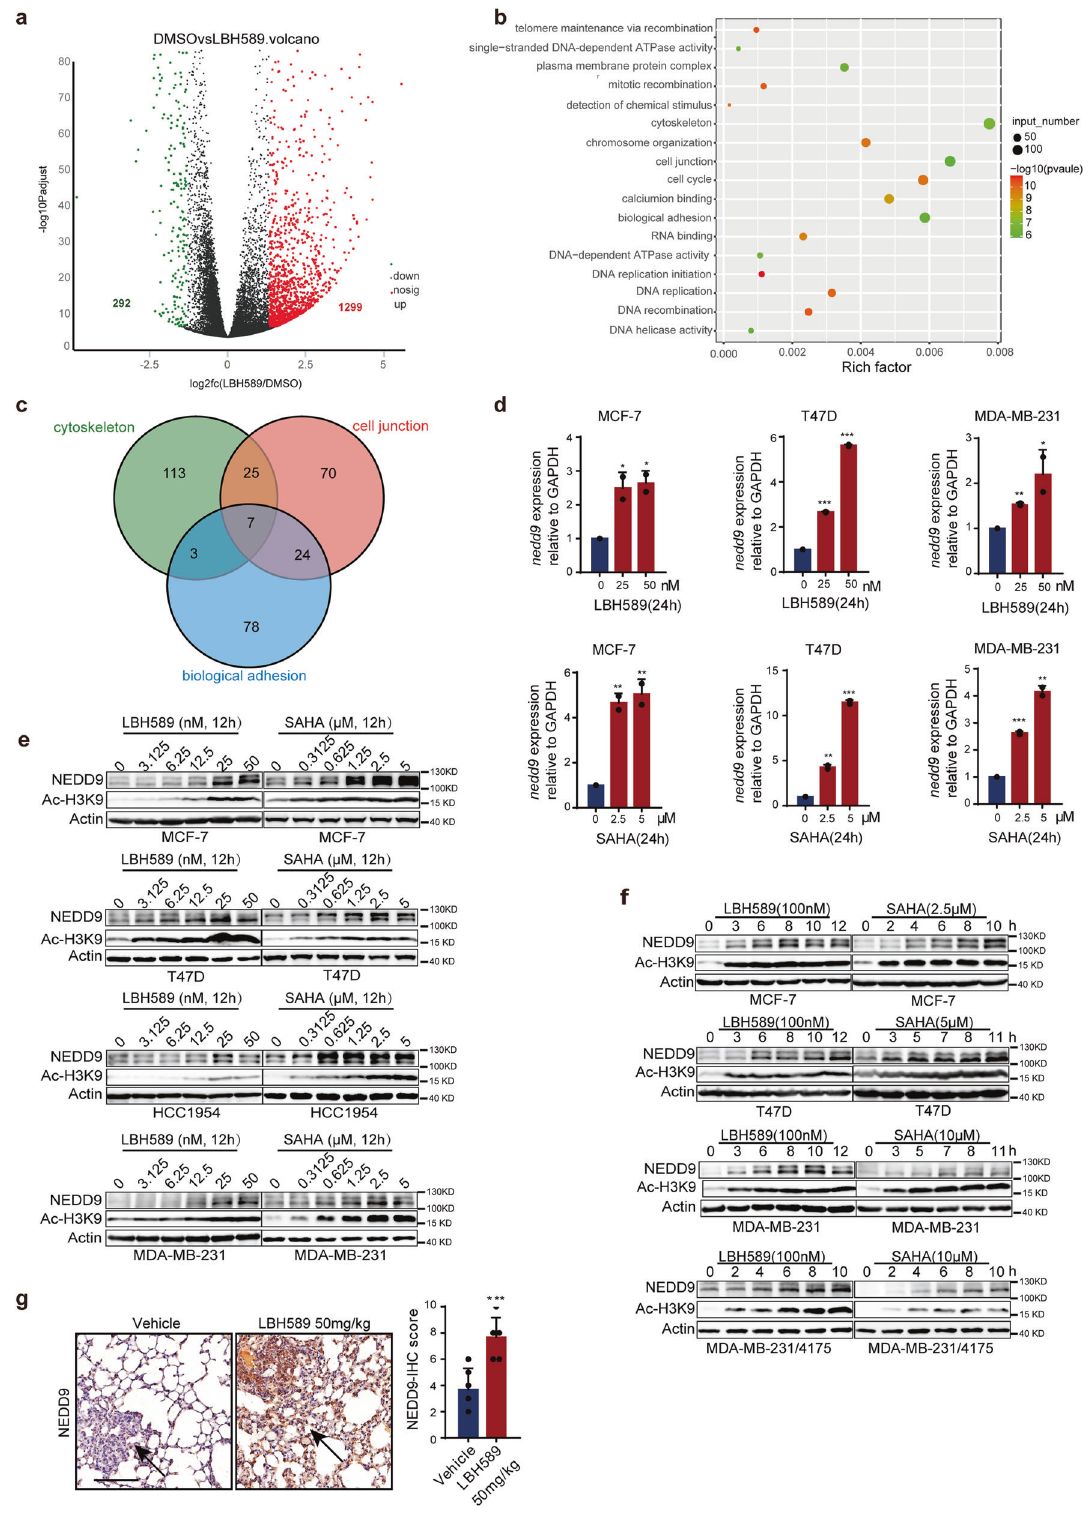
Fig. 2 HDAC inhibitors upregulate NEDD9 expression in breast cancer cells. a RNA sequencing analysis in MCF-7 cells treated with LBH589. 1299 genes were upregulated (p_adjust <0.001, fold change >2.5) and 292 genes were downregulated (p_adjust <0.001, fold change <0.4) in MCF-7 cells after 50nM LBH589 treatment. b GO enrichment analysis. 146 GO of different biological functions were enriched by analyzing 1591 signi fi cantly changed genes in a . c Venn analysis. Seven genes were obtained by intersected cytoskeletal, cell junction and biological adhesion associated with cell migration in b . Relative nedd9 mRNA ( d ) and protein levels ( e , f ) induced by the HDAC inhibitors LBH589 and SAHA. g IHC staining indicated that NEDD9 expression was upregulated in lung metastatic nodules of lung sections after administrating 50mg/kg LBH589. Scale bar, 100 μ m. The arrows show NEDD9 staining. Wald test is used to analyze the differential genes expression and the Fisher ‘ s exact test is employed to GO enrichment analysis. Other results are expressed as mean ±SD. Two-tailed Student ’ s t -tests were performed. * p <0.05, ** p <0.01, *** p <0.001 Signal Transduction and Targeted Therapy (2023)